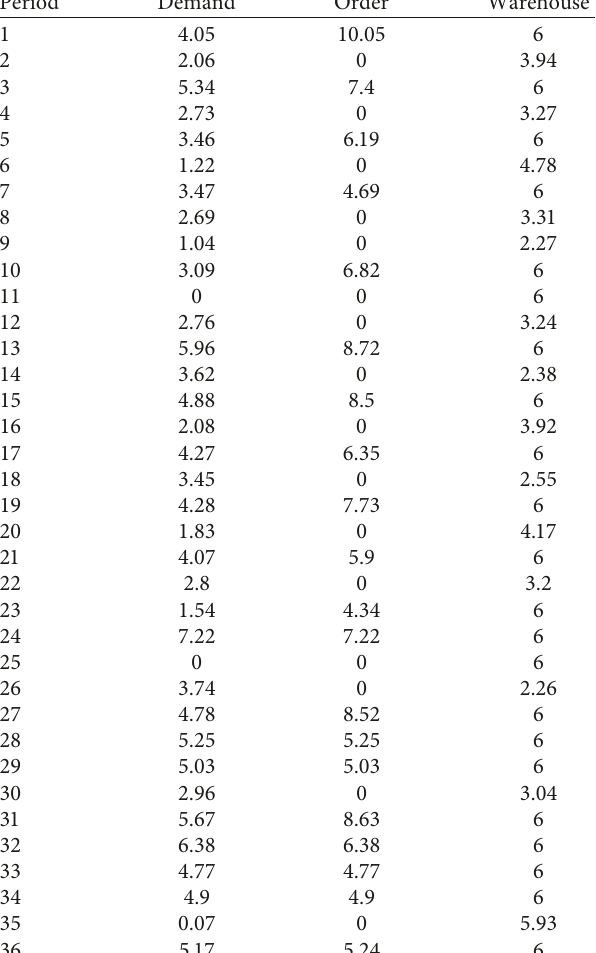
Rest of Table 9. Values of bullwhip effect resulting from the simulation.